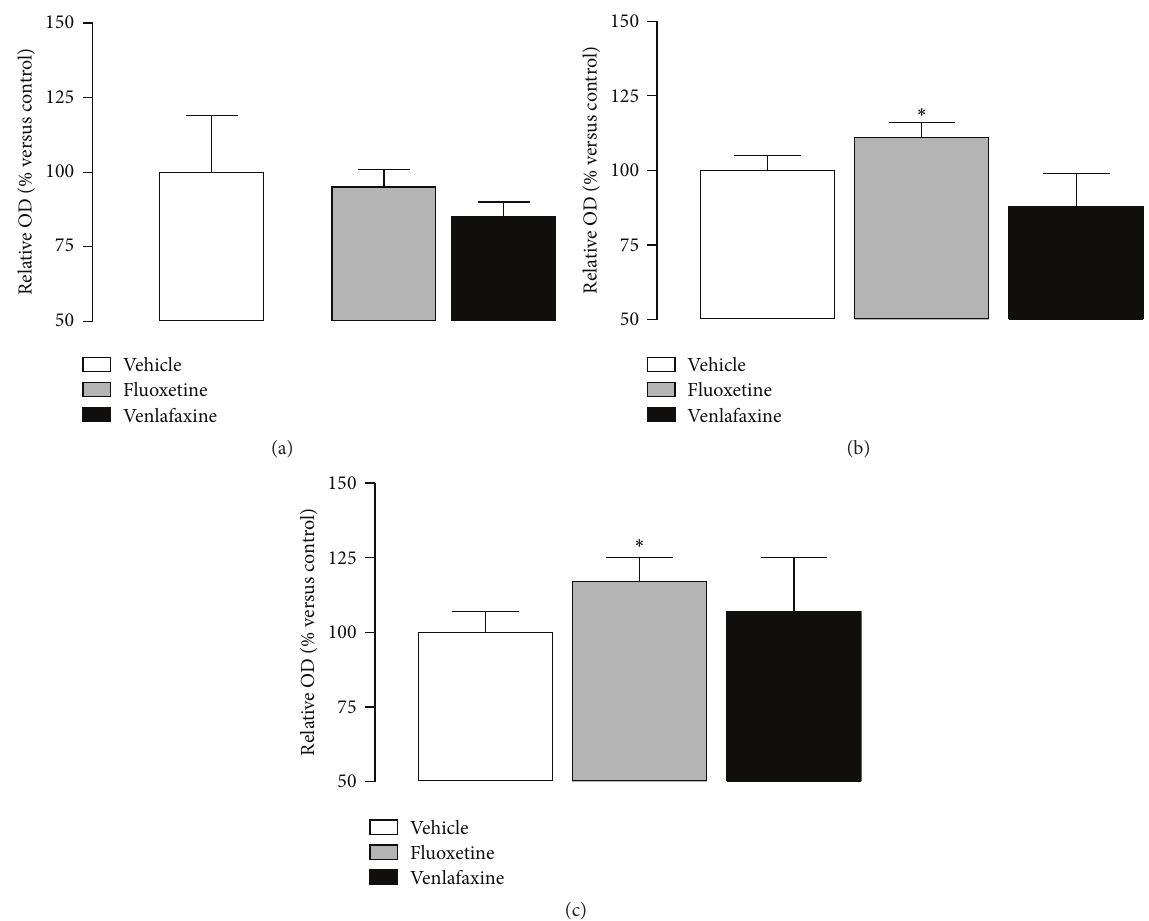
Figure 4: Western blot analyses of hippocampal CREB (a) and p-CREB (b) levels and ratio p-CREB/CREB (c) after chronic antidepressant treatment (14 days) with fluoxetine (10mg/kg/day) and venlafaxine (40mg/kg/day). Note that p-CREB levels and ratio p-CREB/CREB are increased after fluoxetine treatment, but not total CREB, or after venlafaxine treatment in total cell lysate from hippocampus of rats. Values are means ± S.E.M. Corresponding to densitometry levels of the proteins expressed as the percentage of the same proteins in vehicle-treated animals. ∗ 𝑃 < 0.05 versus vehicle. Modified from Mostany et al., 2008 [10], and Mato et al., 2010 [100].